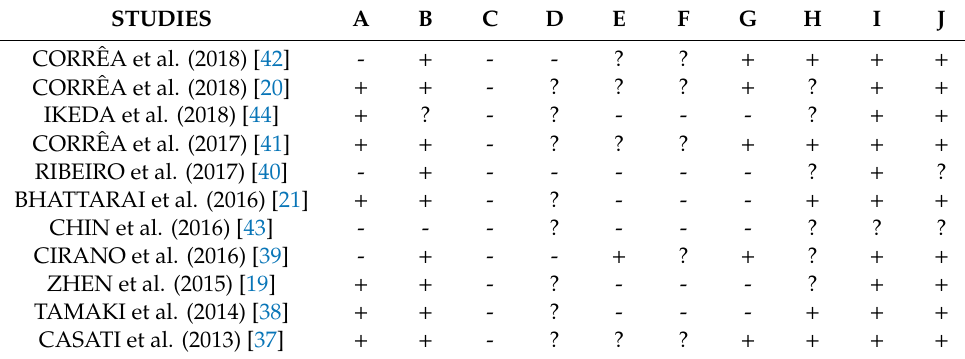
Table 3. An assessment of the risk of bias in the included